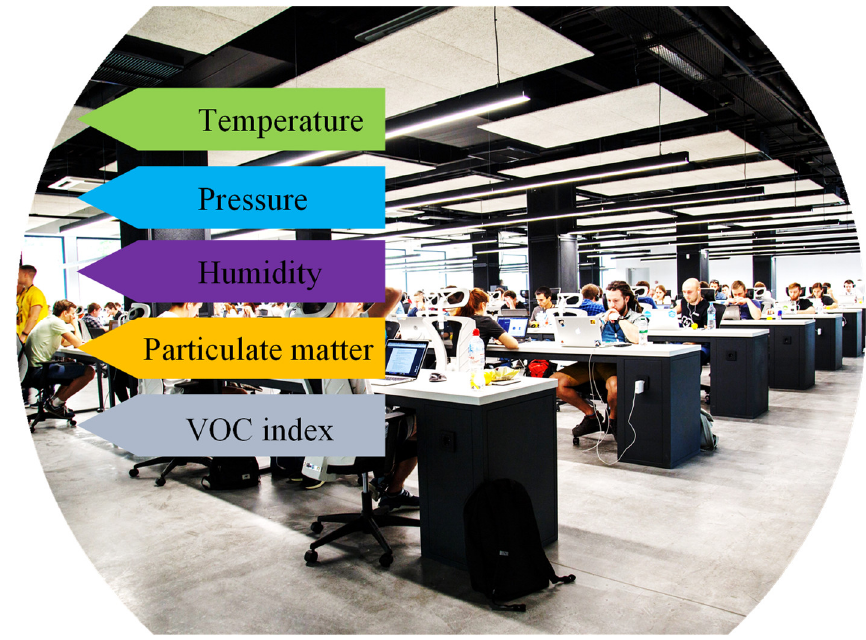
Figure 7. Indoor environment monitoring.